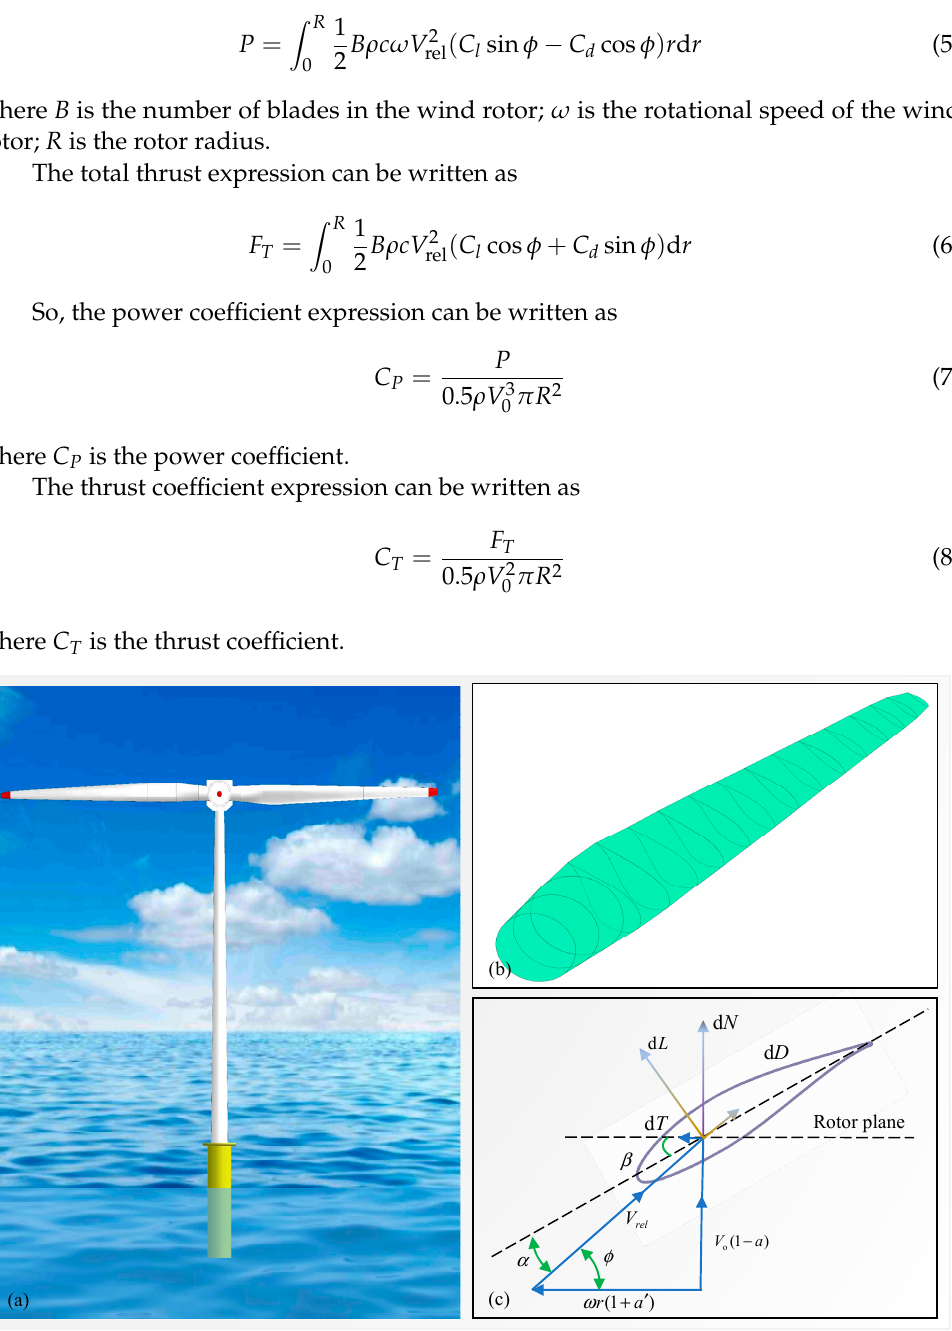
Figure 2. Wind turbine, blade, and elemental forces. ( a ) Wind turbines; ( b ) Wind turbine blade; ( c ) Local elemental forces. ( c ) Local elemental